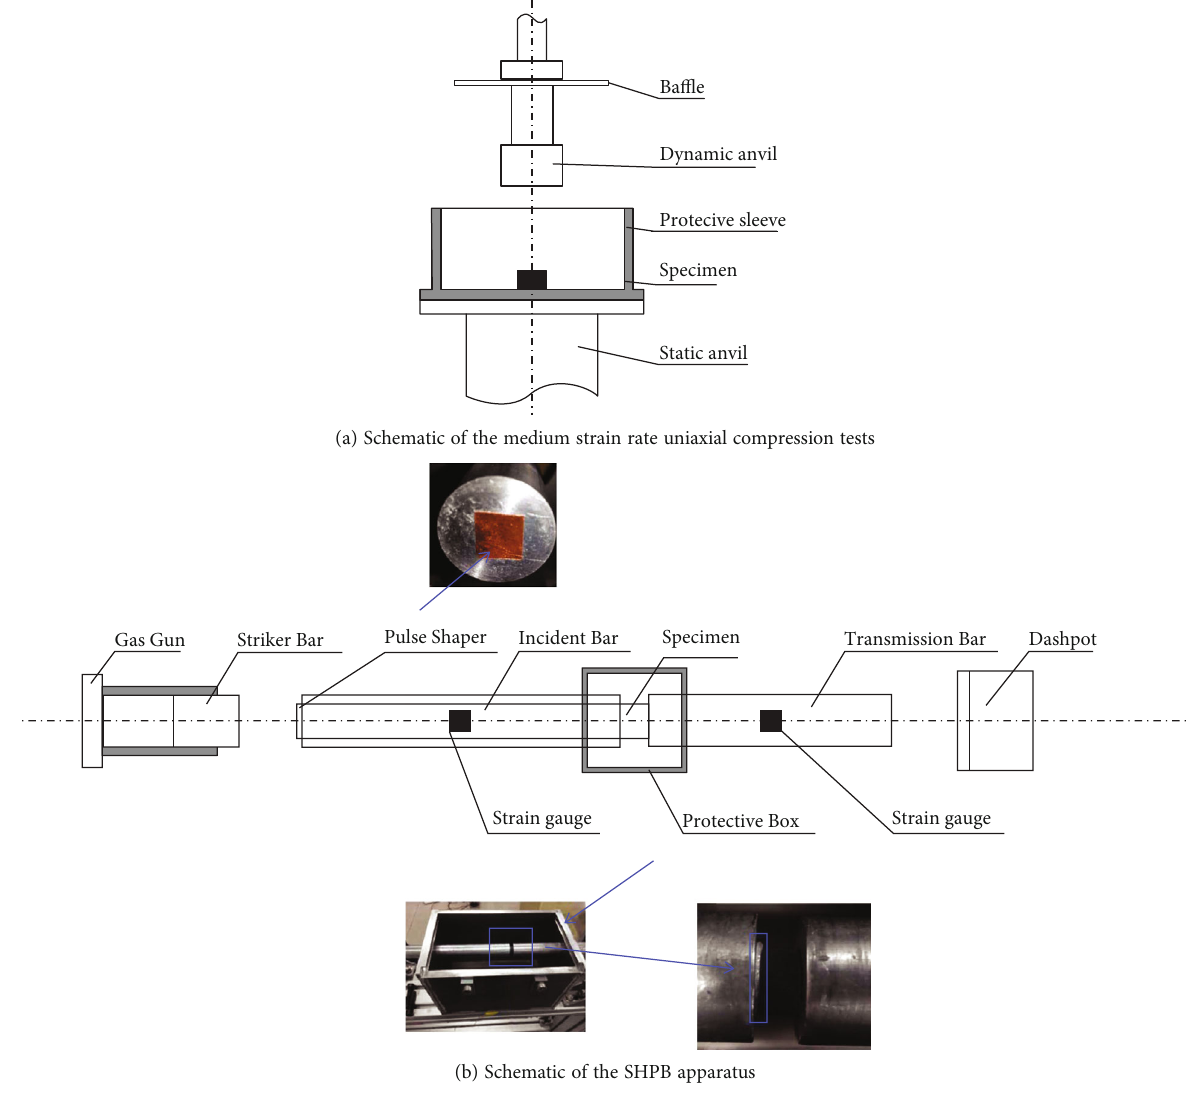
Figure 2: Schematic diagram of experimental